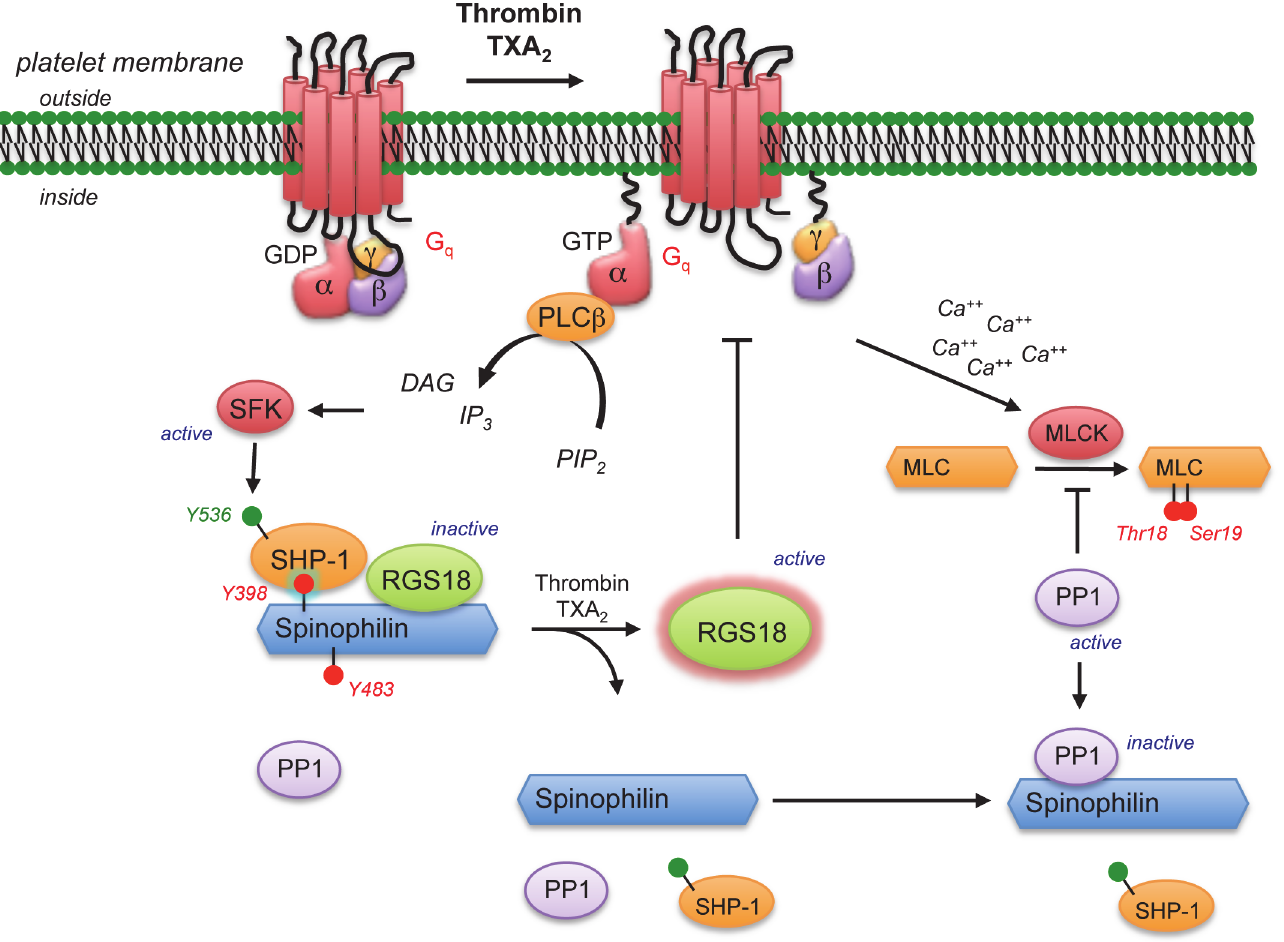
Fig 7. Agonist-induced dissociation of the SPL/RGS/SHP-1 complex and formation of the SPL/PP1 complex. In resting platelets spinophilin is phosphorylated on Y398 and Y483 and bound to either RGS10 or RGS18. Platelet activation by agonists for thrombin or TxA 2 receptors activates SHP-1 by causing phosphorylation of SHP-1(Y536). This triggers dissociation of the SPL/RGS/SHP-1 complex, allowing RGS10 and RGS18 to inhibit signaling. Dissociation of SHP-1 from spinophilin is followed by binding of PP1. Binding to spinophilin inhibits the phosphatase, promoting phosphorylation of PP1 substrates such as myosin light chain